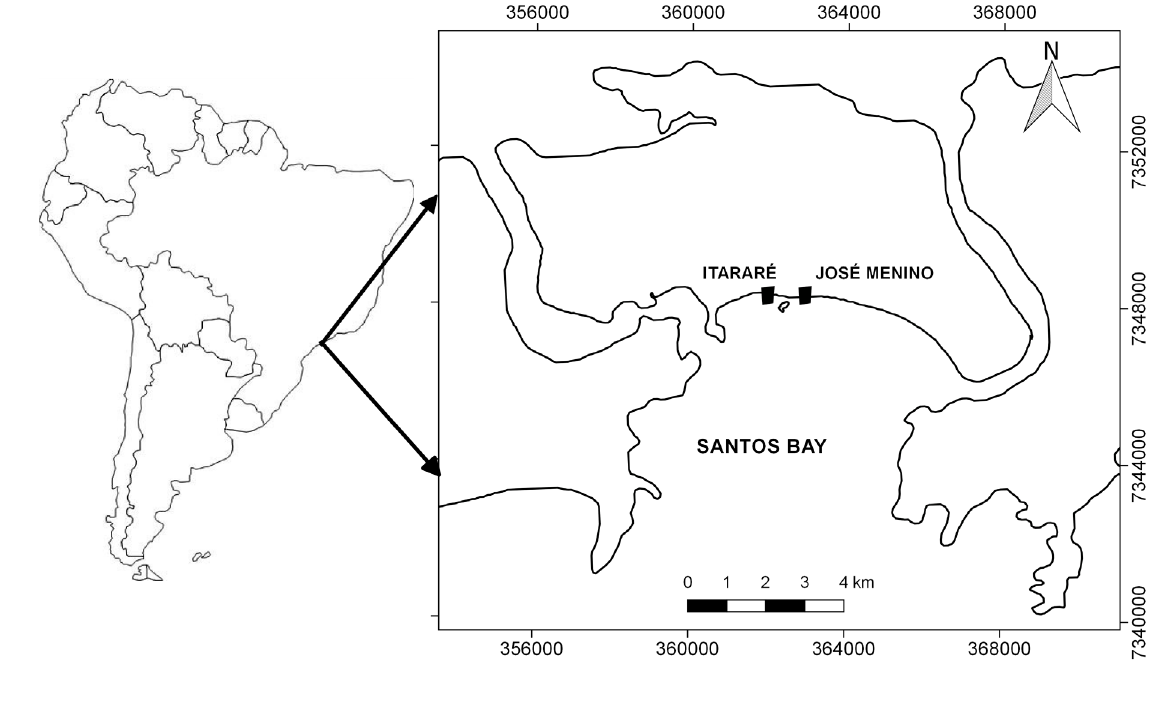
Figure 1. Location of the study beaches in Santos Bay, state of São Paulo, Brazil Google Earth (2018). UTM, Datum WGS